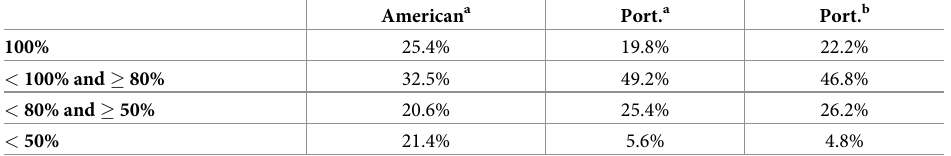
Table 2. Proportion of stimuli with %NA equal to 100%, between 100% and 80%, between 80% and 50%, and below 50%, in each